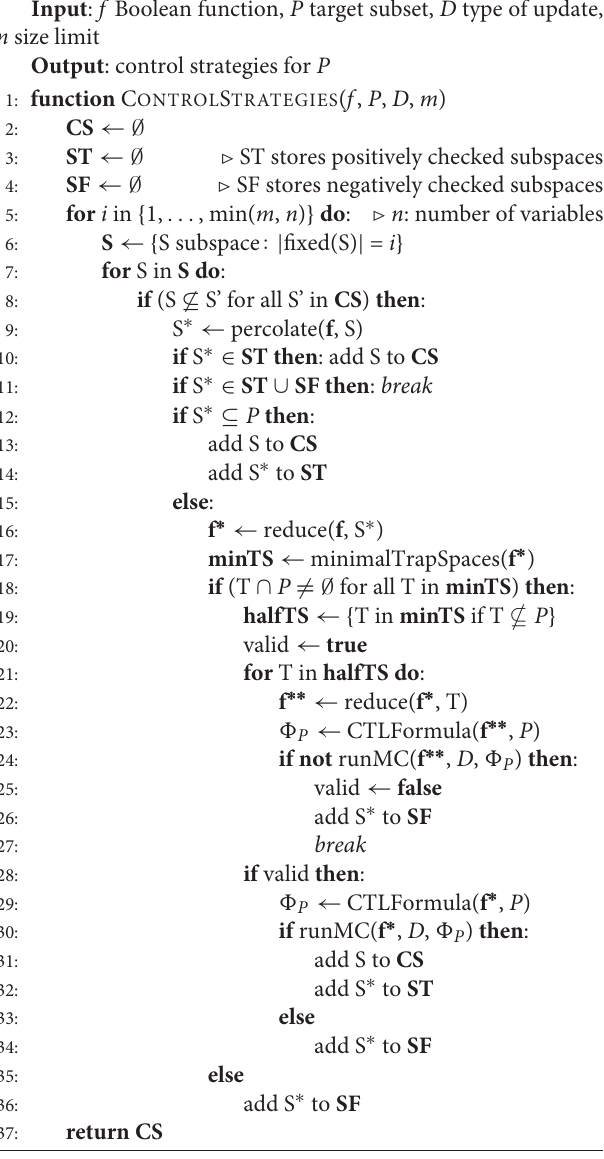
Algorithm 1 | Control strategies for a target